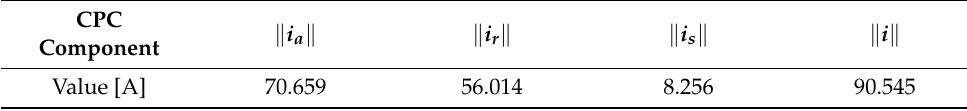
Table 4. List of RMS values of currents in CPC